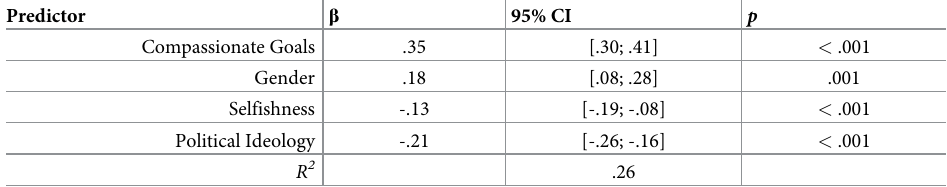
Table 13. Coefficients from multiple regression models predicting COVID-19 health behaviors across three studies. Predictor